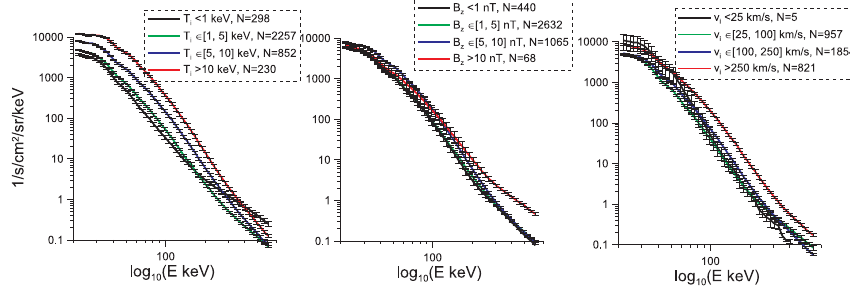
Figure 2. Averaged spectra of ions for different ranges of system parameters.